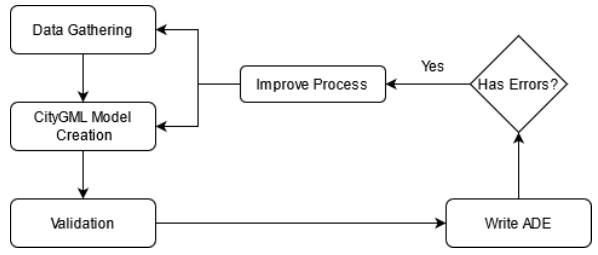
Figure 1. Quality Management